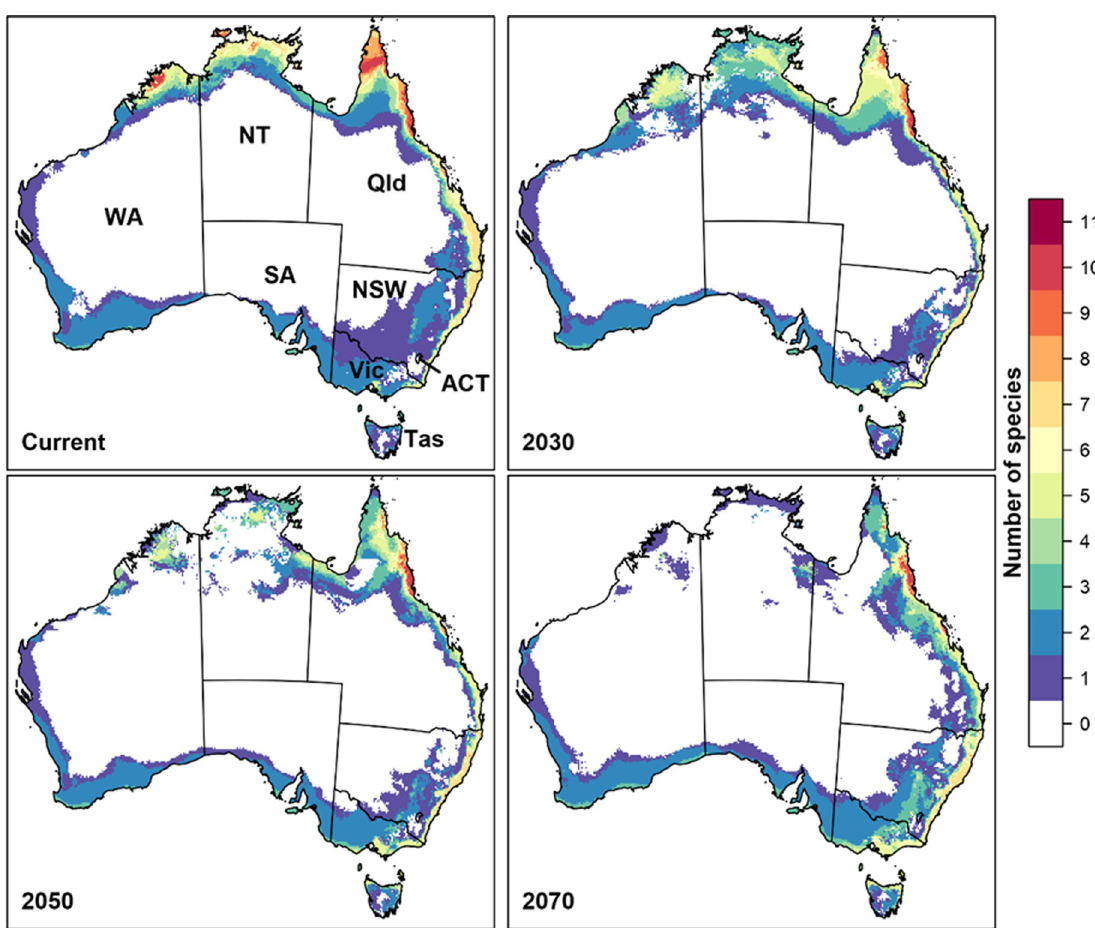
Fig 2. Hotspot maps of habitat suitability for the 11 fruit fly species under climate change, when novel environments are excluded. Hotspot maps of baseline (1960–1990) and future habitat suitability for 11 fruit flies. Suitability was modelled with Maxent, and thresholded using the 10th percentile at training presence localities. These maps exclude regions containing novel environments (see S1 File for individual species maps with novel environments excluded) . Colours indicate the number of species for which habitat is projected to be suitable under the majority ( � 4) future climate scenarios. Figure was created in R version 3.3.3 [57] (https://www.R- project.org/).